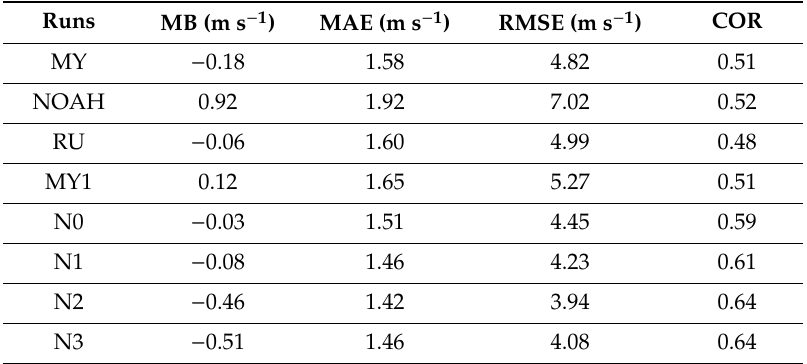
Table 5. Summary of the statistics between predicted and measured 10 m wind speed at meteorological aviation reporting (METAR) stations in the Northern Sahara.